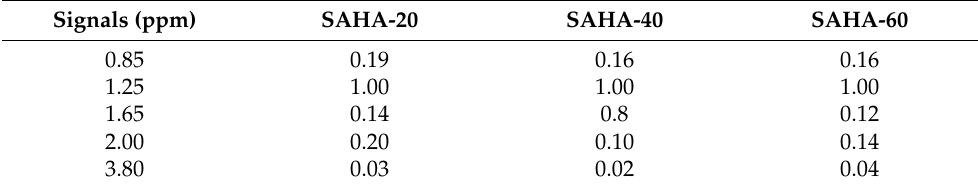
Table 3. 1 H NMR signal ratio with the signal that appears at 1.25 ppm.